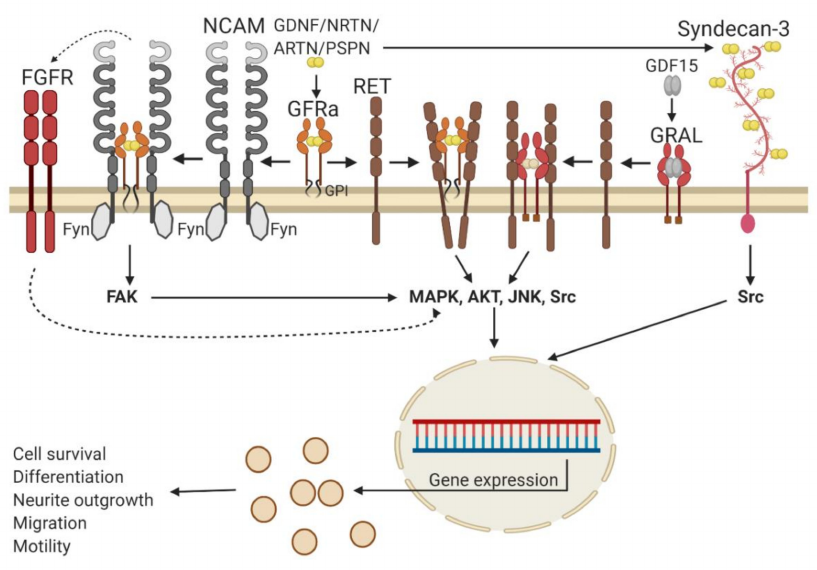
Figure 2. Glial cell line-derived neurotrophic factor family ligands (GFLs) signaling. The main signaling receptor for GFLs is receptor tyrosine kinase RET (REarranged in Transfection), which they activate upon binding to a glycosylphosphatidylinositol (GPI)-anchored coreceptor GDNF family receptor alpha (GFR α ) or transmembrane GFRAL. RET subsequently activates classical receptor tyrosine kinase signaling pathways such as MAPK, AKT, JNK and Src, which are important for the cell survival and neurite outgrowth. In addition, GFLs in the presence of GFR α can signal via the neural adhesion molecule (NCAM) associated with the Fyn kinase, promoting cell migration and neurite outgrowth. GFLs via NCAM can also indirectly activate the fibroblast growth factor receptor (FGFR). Finally, GFLs can bind syndecan-3 and activate the Src pathway, contributing to neuronal precursor migration. Please, notice that the cognate GFR α receptor for persephin (PSPN) contains only two extracellular cysteine-rich domains. For simplification, this is not reflected in the scheme. Solid arrows indicate direct interactions and subsequent events, dotted arrows—indirect activation of certain pathways. GDNF—glial cell line-derived neurotrophic factor, NRTN—neurturin and ARTN—artemin. Created with